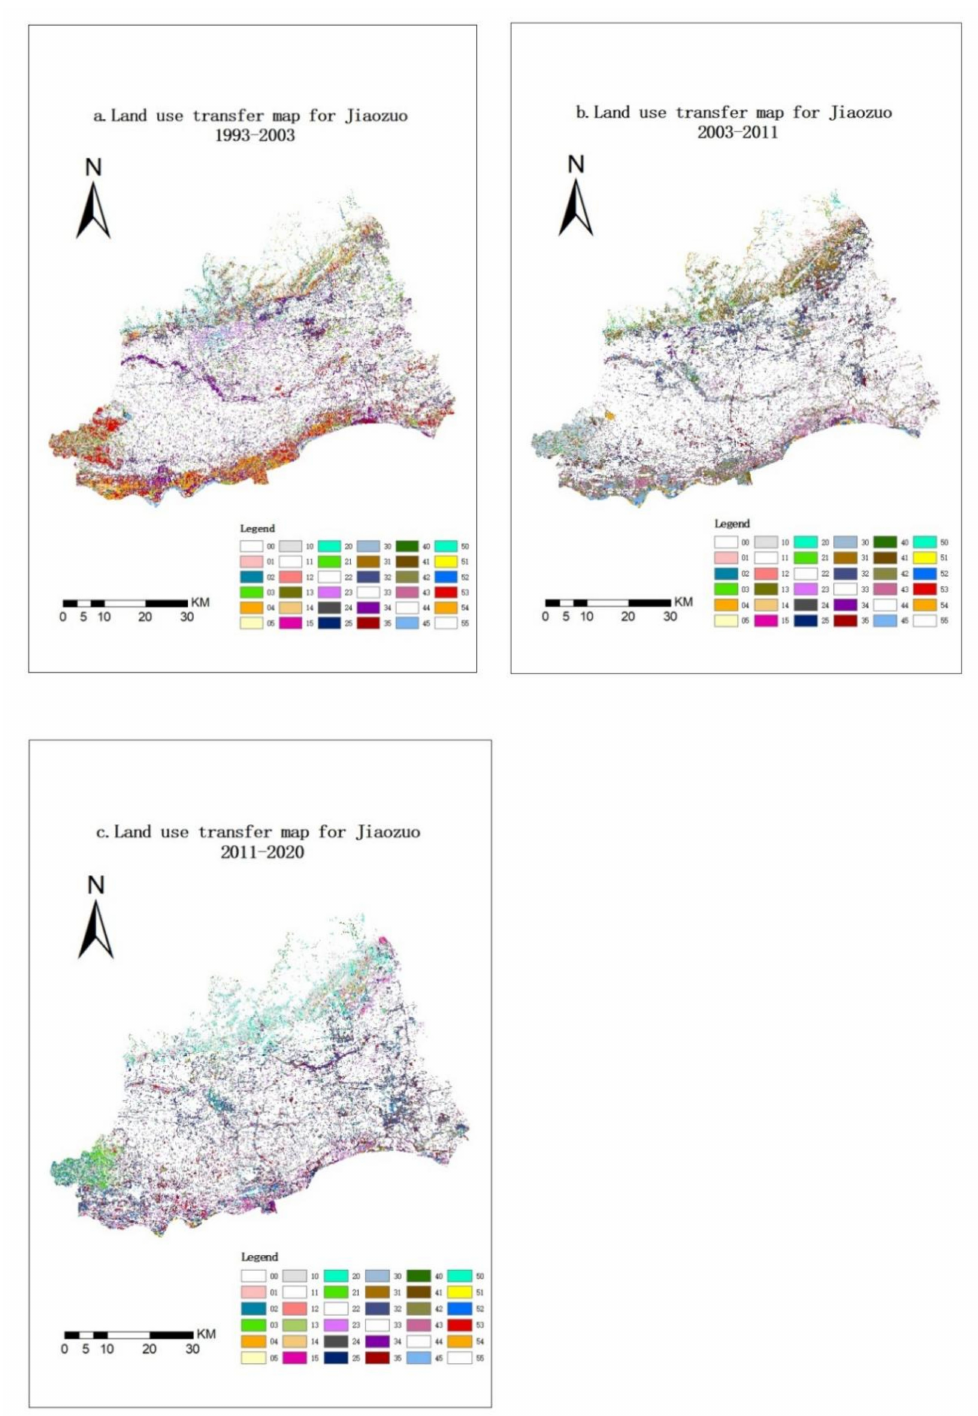
Figure 8. Land use transfer map for Jiaozuo